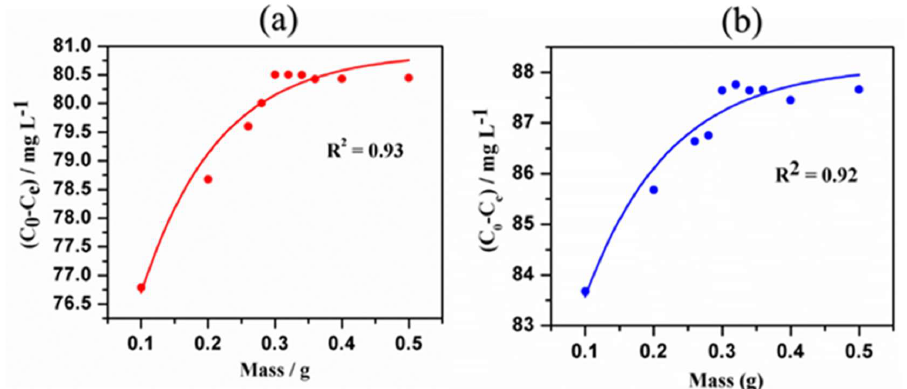
Figure 9. Plot of amount adsorbed of ( a ) Ni 2+ and ( b ) Cd 2+ ions by hematite nanoparticles with increasing mass.